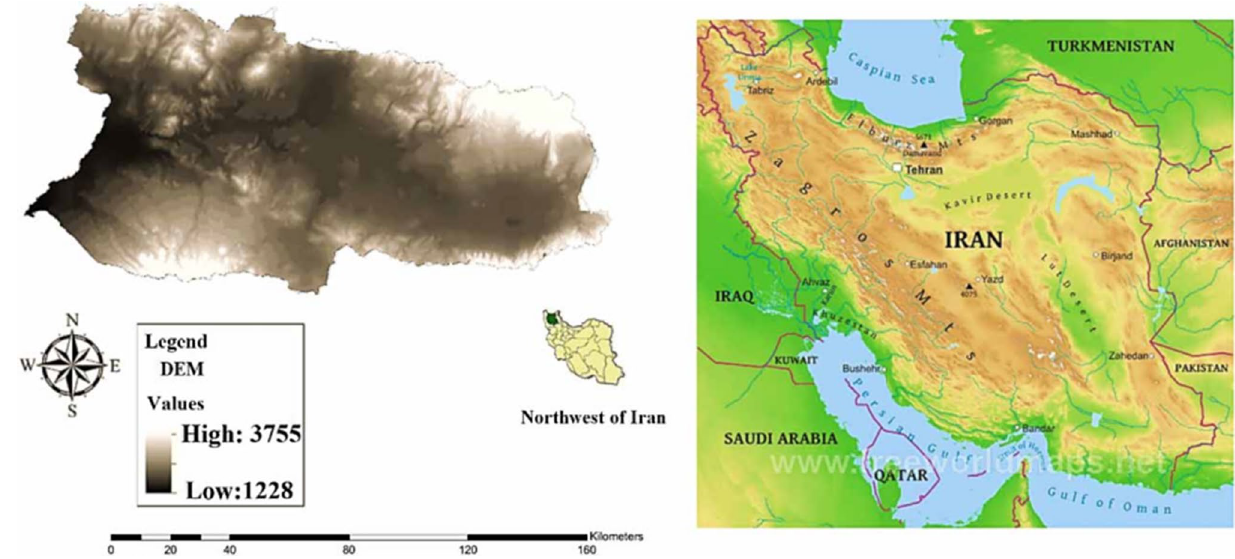
Fig. 1 Location of study area